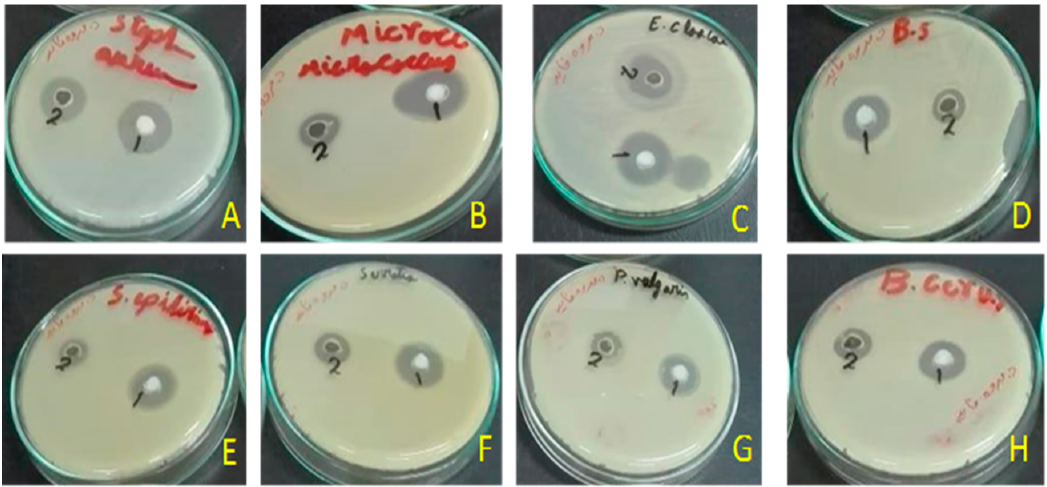
Figure 3. Antimicrobial activity of the zinc salt of extract (1) and the total sunflower-oil extract (2) of